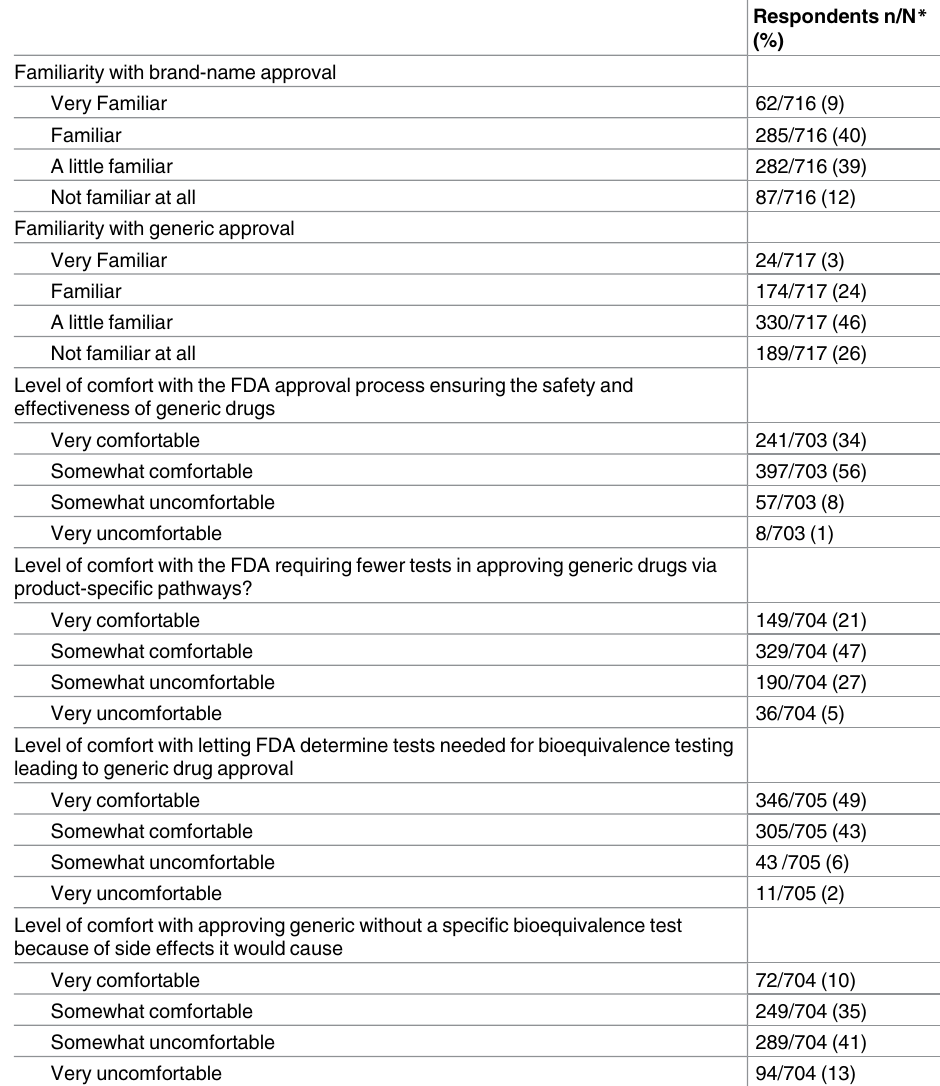
Table 2. Physicians’ familiarity and comfort with the FDA drug approval